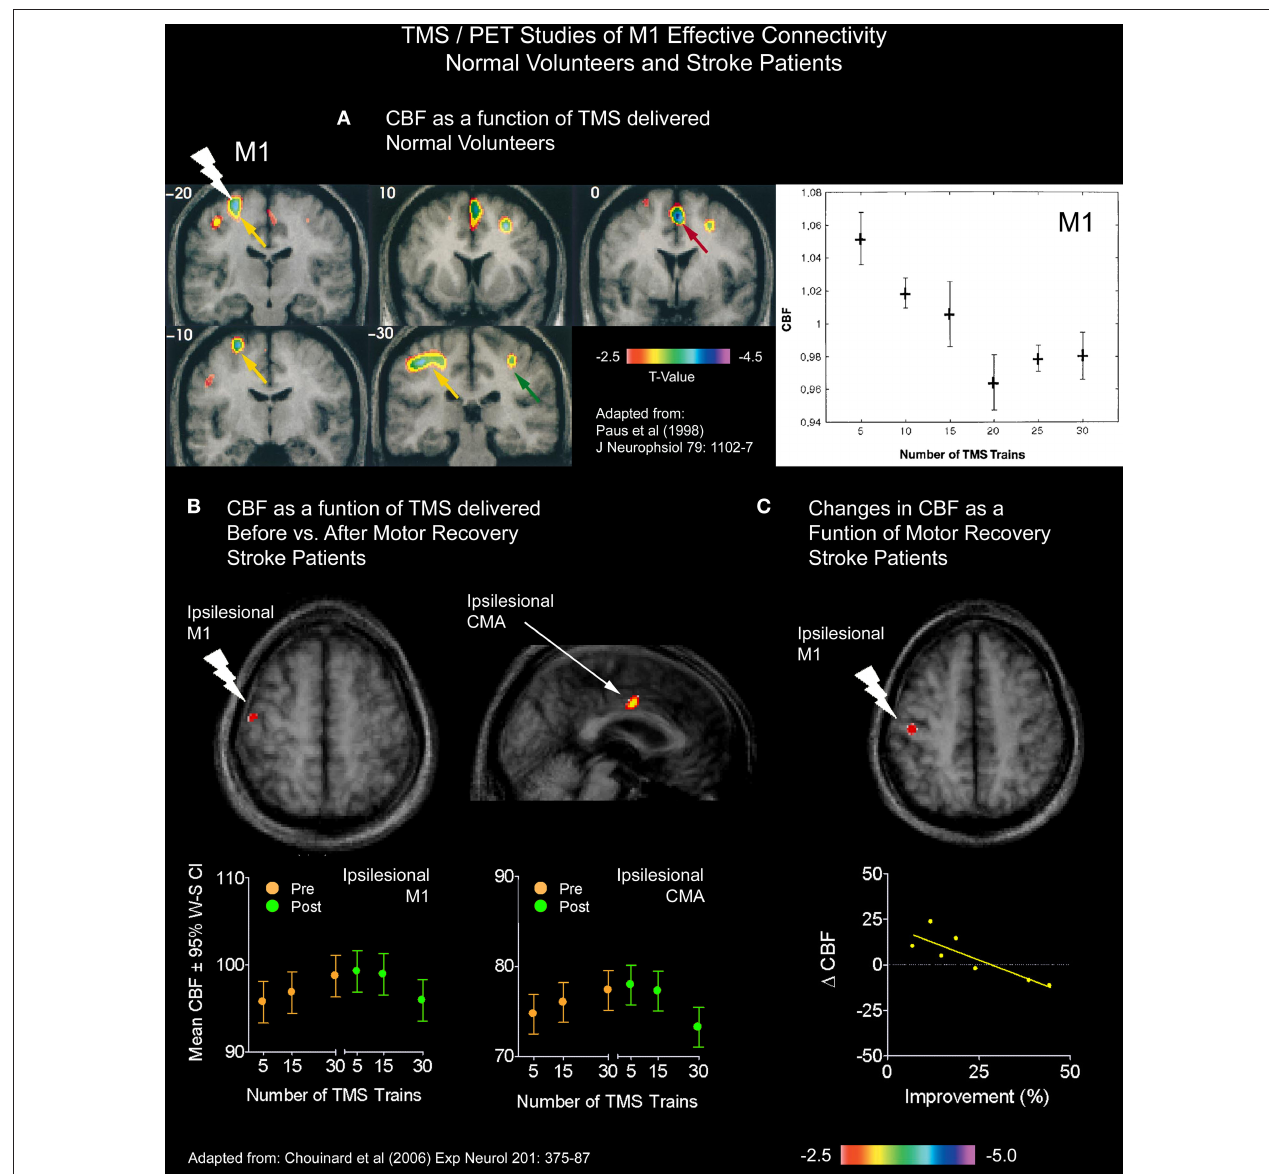
Figure 4 | TMS/PeT studies of M1 effective connectivity on normal volunteers and stroke patients. (A) Paus et al. (1998) applied sub-threshold 10-Hz repetitive TMS over M1 and varied the number of TMS trains delivered during each block of PET scanning. In doing so, the CBF response correlated negatively with the number of stimulus trains delivered both at the site of stimulation and in several distal brain regions. Given the success of this protocol in normal volunteers, we carried out the same procedures before and after the stroke patients had their CI therapy. (B) In one analysis, we asked whether or